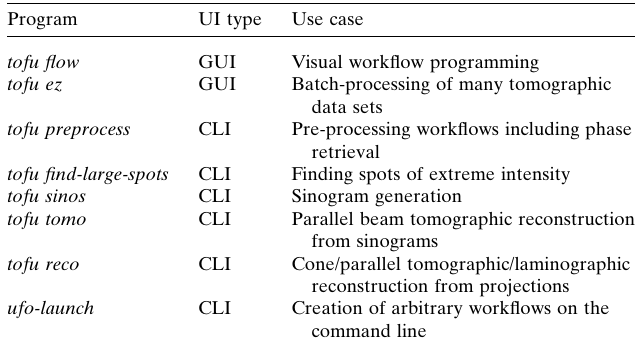
Table 2 User interfaces and their typical use